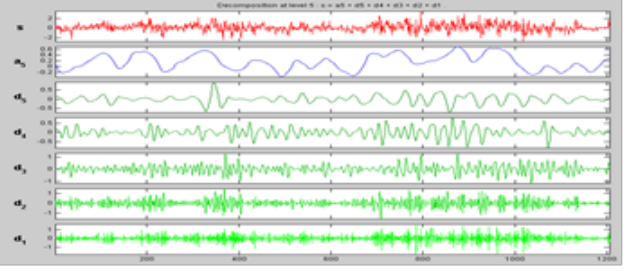
Figure 2. Original and filtered quantities of total return index of Tehran Stock Exchange for